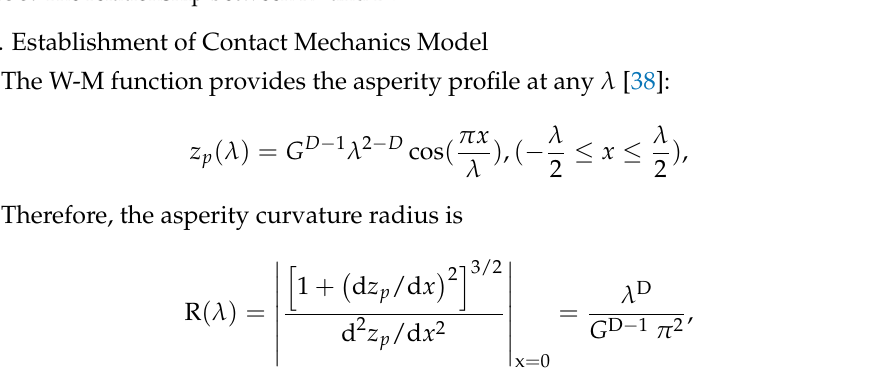
Figure 5. The relationship between R 2 and D